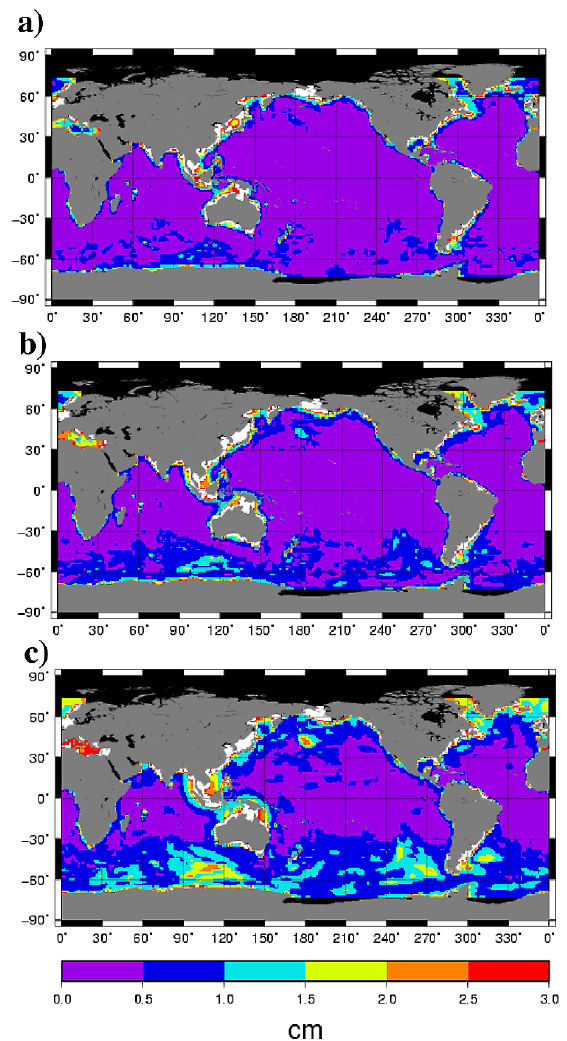
Fig. 1. Standard deviation of differences between unsmoothed OBP from JPL ECCO and (a) JPL ECCO OBP truncated to spherical harmonic degree/order 40 and smoothed with a 300km Gaussian, (b) JPL ECCO OBP truncated to degree/order 40 and smoothed with a 500km Gaussian, and (c) JPL ECCO OBP truncated to de- gree/order 40 and smoothed with a 750km Gaussian.